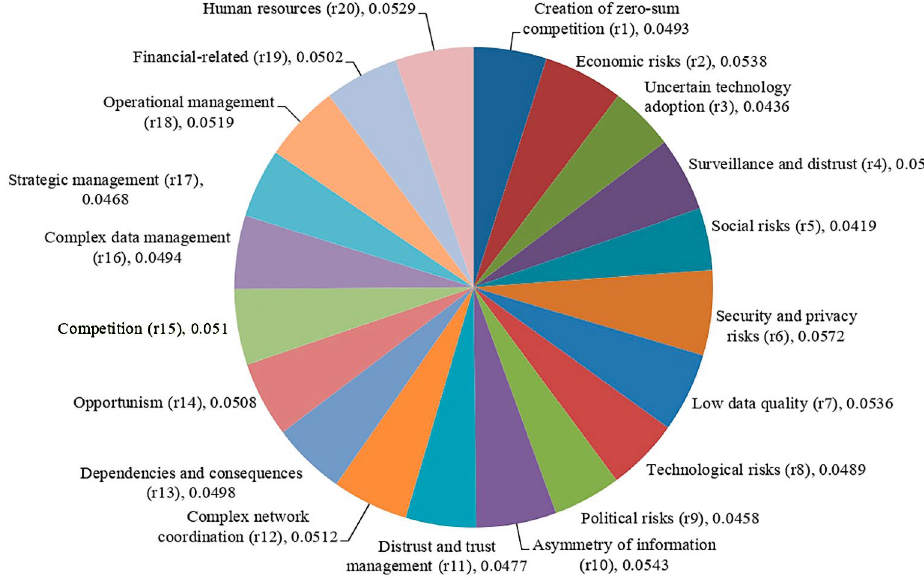
Figure 1. Significance values/weight of different IoT risks for supply chain